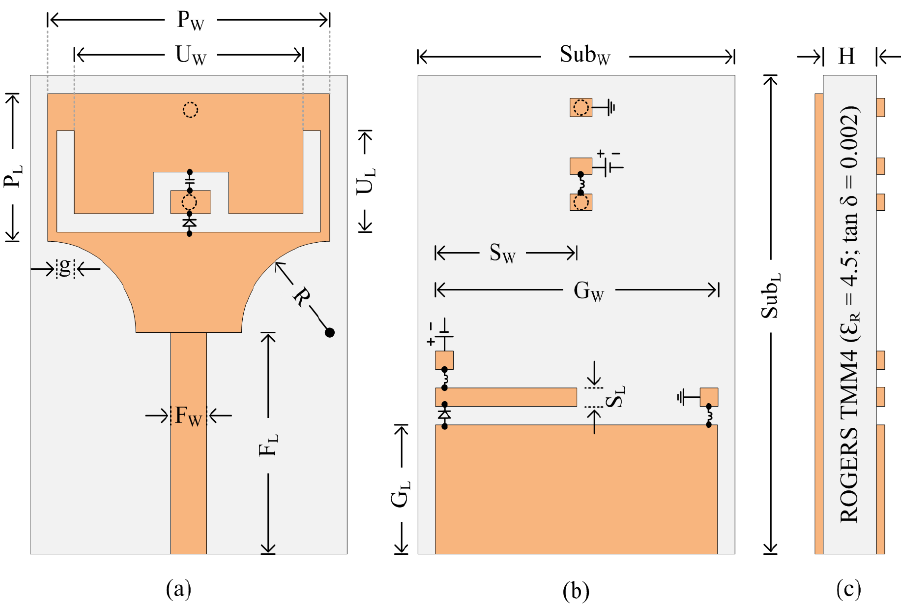
Figure 1. ( a ) Top ‐ view; ( b ) bottom ‐ view; ( c ) and side ‐ view of the proposed reconfigurable notch band antenna. band